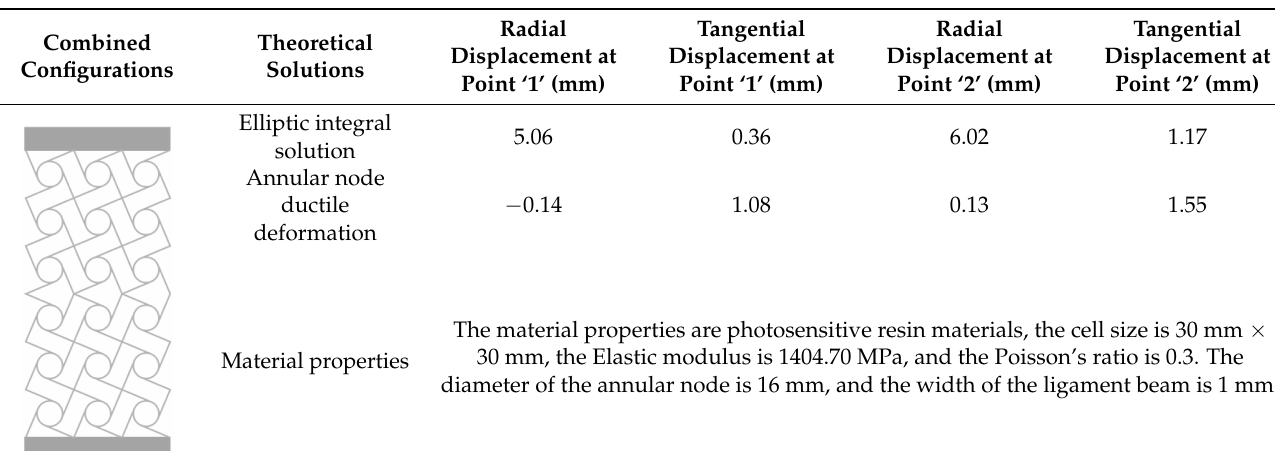
Figure 11. Two-dimensional planar compression–shear coupling deformation of chiral cells. (The red dotted line is the compression-shear deformation on one side of the structure.) Table 1. Displacements of ligament beam